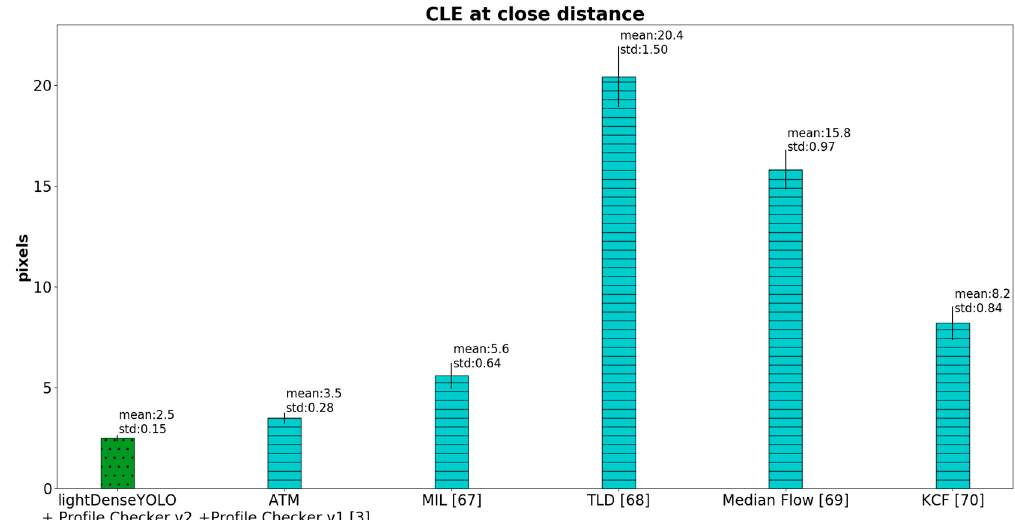
Figure 19. CLE comparison between our method and non-CNN marker trackers.